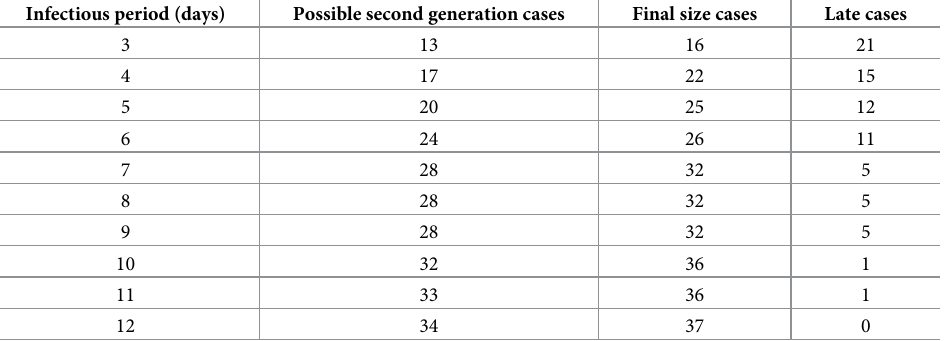
Table 2. The number of possible second generation cases, final size cases, and late cases for each assumed infec- tious period. There are always 37 total final size and late cases. Infectious period (days)